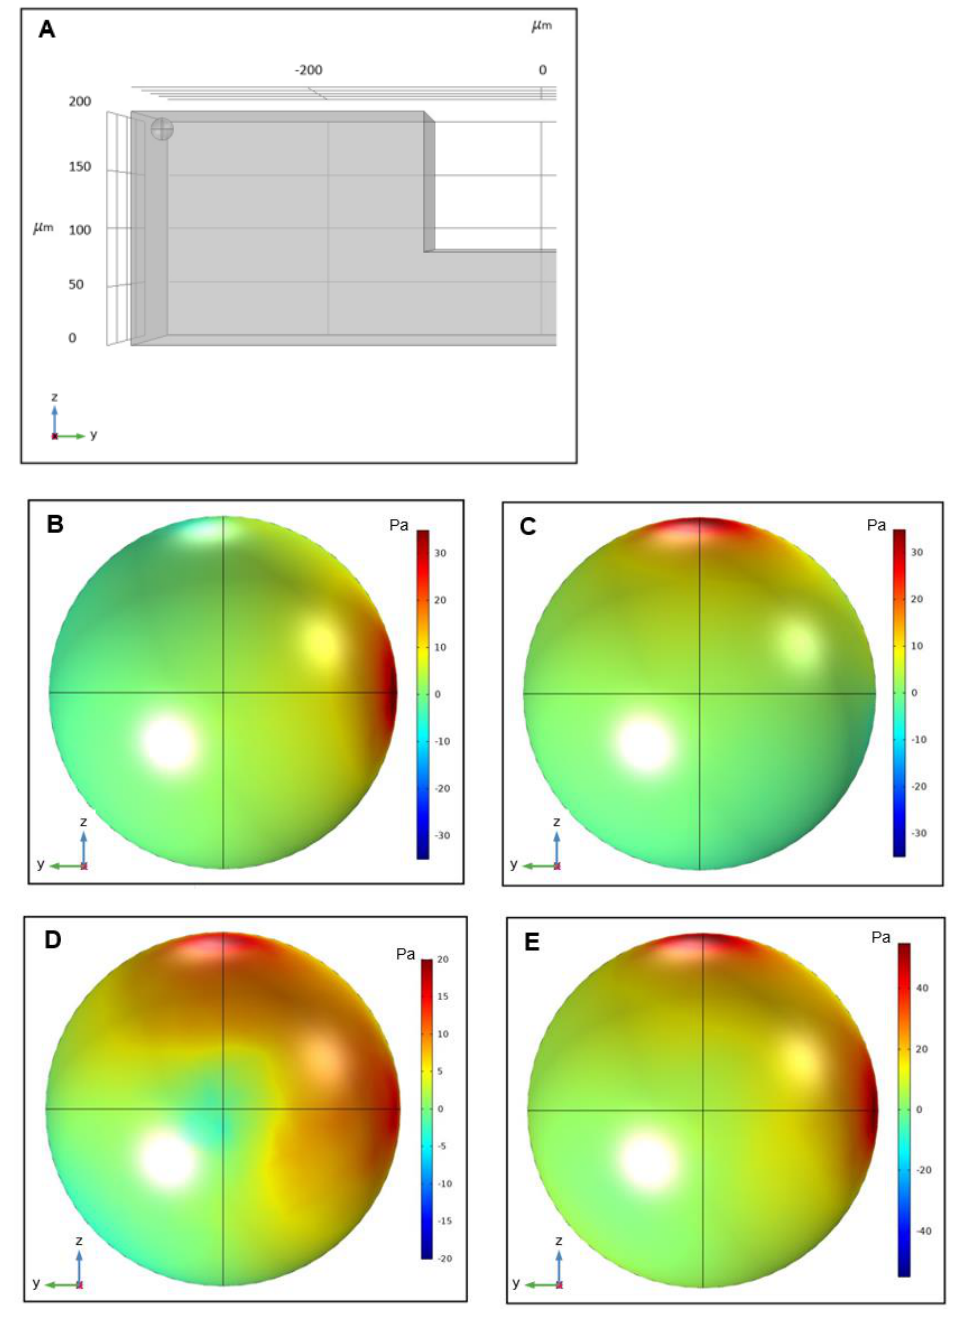
Figure 8. Schematic of ( A ) the critical location for a 14 µm particle in terms of experiencing the maximum shear stress throughout the spiral microchannel, ( B ) the total shear stress exerting on the particle in the x-direction, ( C ) the total shear stress exerting on the particle in the y-direction, ( D ) the total shear stress exerting on the particle in the z-direction, ( E ) the total magnitude of shear stress exerting on the particle. The resulting maximum stress in the x, y, and z-direction was found to be 35 Pa, 35 Pa, and 20 Pa, respectively. Moreover, the maximum value for the magnitude of total shear stress is 45 Pa.